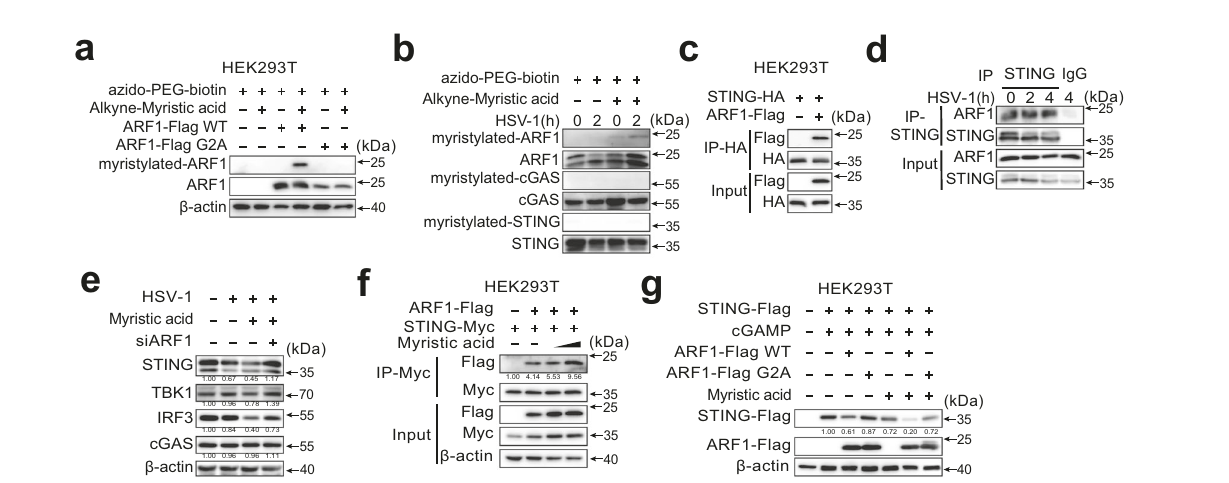
Fig. 6 | NMT1 attenuates cGAS-STING pathway. a Quantitative polymerase chain reaction (qPCR) analysis of Nmt1 or Nmt2 mRNA in peritoneal macrophages (PMs) during HSV-1 infection, n =3 samples examined over 3 independent experiments. b ImmunoblotanalysisofNMT1inPMsduringHSV-1infection. c Luciferaseactivity analysis of interferon (IFN)- β activation in HEK293T cells transfected with empty vectororcGASplusSTINGplasmids,togetherwithN-myristoyltransferase1(NMT1) plasmid or empty vector plasmid, n =4 samples examined over 3 independent experiments. d Immunoblot analysis of NMT1 expression in PMs transfected with negativecontrolsiRNA(siNC)or Nmt1 siRNA(si Nmt1 )for48h. e , f qPCRanalysisof Ifnb1 mRNA expression in PMs transfected with siNC or si Nmt1 , followed by HSV-1